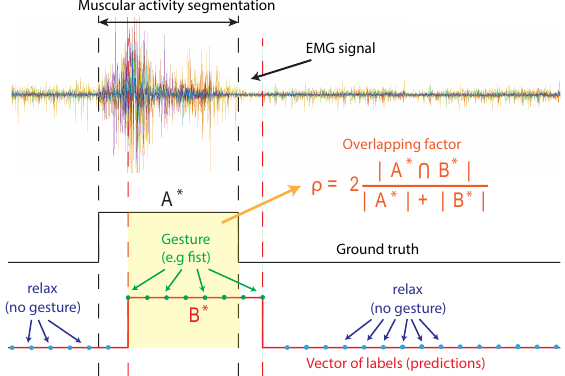
Figure 6. Calculation of value ρ through overlapping among ground-truth and the vector of predictions. If overlapping factor for each EMG sample is more than ρ = 0.25, then we consider that the recognition is